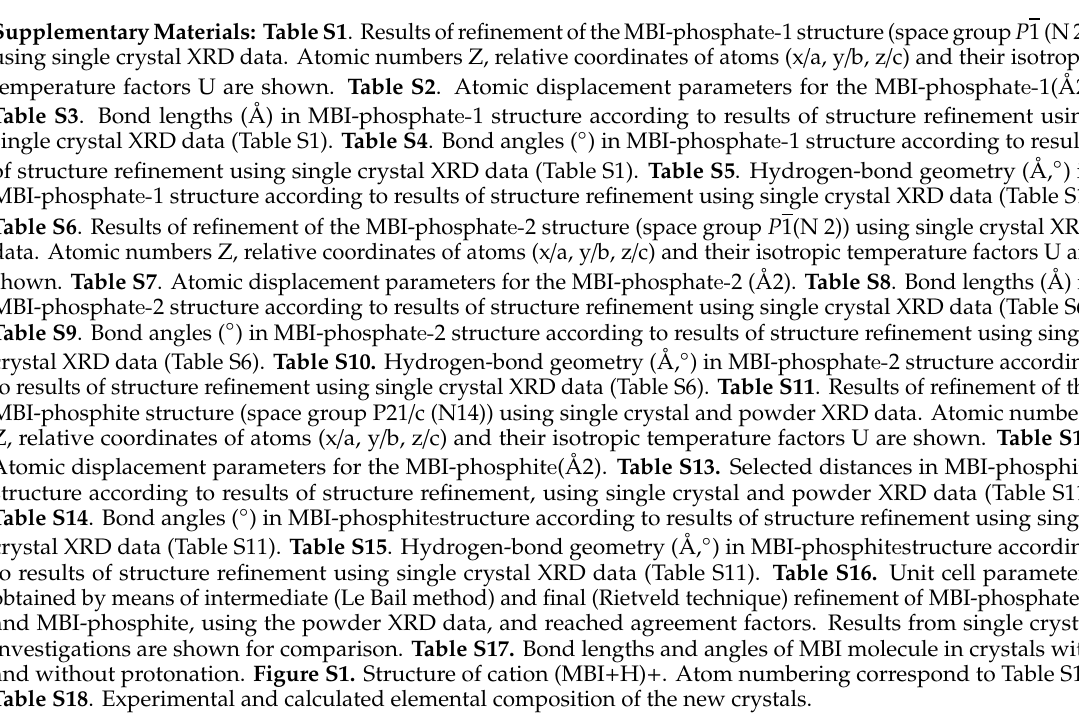
Supplementary Materials: Table S1 . Results of refinement of the MBI-phosphat е- 1 structure (space group P 1 (N 2)) using single crystal XRD data. Atomic numbers Z, relative coordinates of atoms (x / a, y / b, z / c) and their isotropic temperature factors U are shown. Table S2 . Atomic displacement parameters for the MBI-phosphat е- 1(Å2). Table S3 . Bond lengths (Å) in MBI-phosphat е- 1 structure according to results of structure refinement using single crystal XRD data (Table S1). Table S4 . Bond angles ( ◦ ) in MBI-phosphat е- 1 structure according to results of structure refinement using single crystal XRD data (Table S1). Table S5 . Hydrogen-bond geometry (Å, ◦ ) in Table S6 . Results of refinement of the MBI-phosphat е- 2 structure (space group P 1(N 2)) using single crystal XRD data. Atomic numbers Z, relative coordinates of atoms (x / a, y / b, z / c) and their isotropic temperature factors U are shown. Table S7 . Atomic displacement parameters for the MBI-phosphat е- 2 (Å2). Table S8 . Bond lengths (Å) in MBI-phosphat е- 2 structure according to results of structure refinement using single crystal XRD data (Table S6). Table S9 . Bond angles ( ◦ ) in MBI-phosphat е- 2 structure according to results of structure refinement using single crystal XRD data (Table S6). Table S10. Hydrogen-bond geometry (Å, ◦ ) in MBI-phosphat е- 2 structure according to results of structure refinement using single crystal XRD data (Table S6). Table S11 . Results of refinement of the MBI-phosphite structure (space group P21 / c (N14)) using single crystal and powder XRD data. Atomic numbers Z, relative coordinates of atoms (x / a, y / b, z / c) and their isotropic temperature factors U are shown. Table S12 . Atomic displacement parameters for the MBI-phosphit е (Å2). Table S13. Selected distances in MBI-phosphite structure according to results of structure refinement, using single crystal and powder XRD data (Table S11). Table S14 . Bond angles ( ◦ ) in MBI-phosphit е structure according to results of structure refinement using single crystal XRD data (Table S11). Table S15 . Hydrogen-bond geometry (Å, ◦ ) in MBI-phosphit е structure according to results of structure refinement using single crystal XRD data (Table S11). Table S16. Unit cell parameters obtained by means of intermediate (Le Bail method) and final (Rietveld technique) refinement of MBI-phosphate-1 and MBI-phosphite, using the powder XRD data, and reached agreement factors. Results from single crystal investigations are shown for comparison. Table S17. Bond lengths and angles of MBI molecule in crystals with and without protonation. Figure S1. Structure of cation (MBI + H) + . Atom numbering correspond to Table S17. Table S18 . Experimental and calculated elemental composition of the new